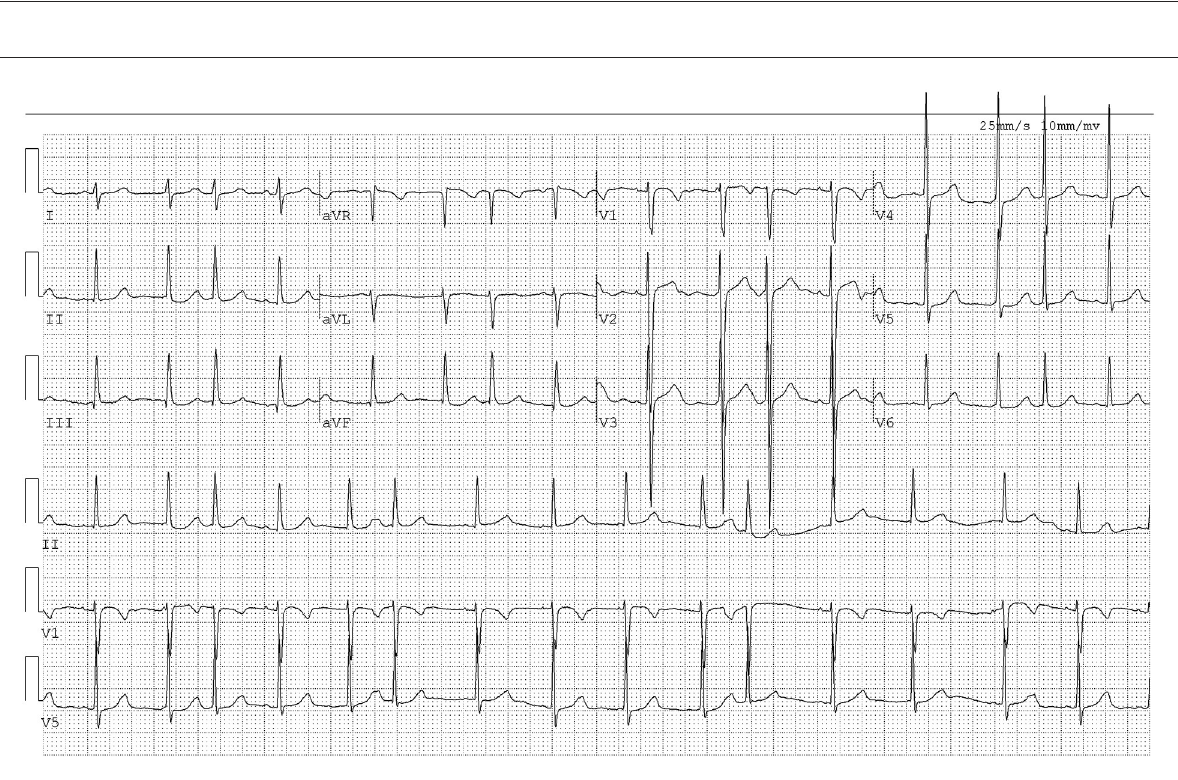
FIGURE2 The ECG of Case 1. The ECG showed sinus arrhythmia and frequent premature atrial